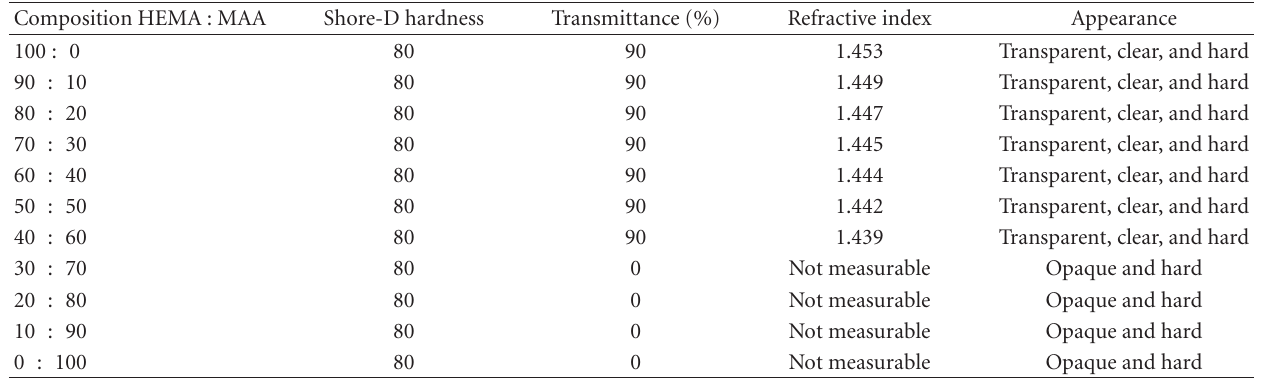
Table 4: Properties of polymers obtained with HEMA : MAA by varying ratios.